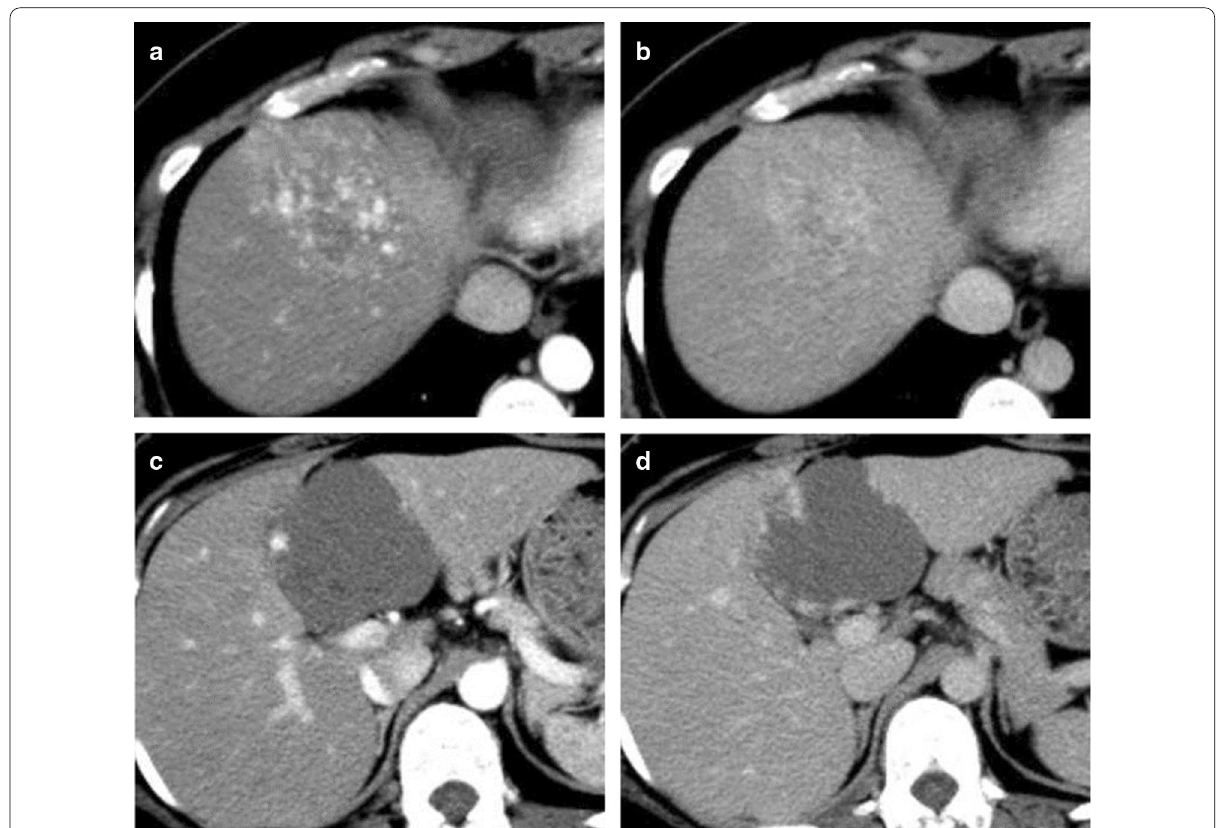
Fig. 2 Enhanced CT findings. a , b Multiple ill-defined spots are heterogeneously enhanced in liver segment IVa. c , d An enhanced abdominal CT scan shows peripheral enhancement in the arterial phase ( c ) and fill-in contrast in the late phase ( d ) in liver segment